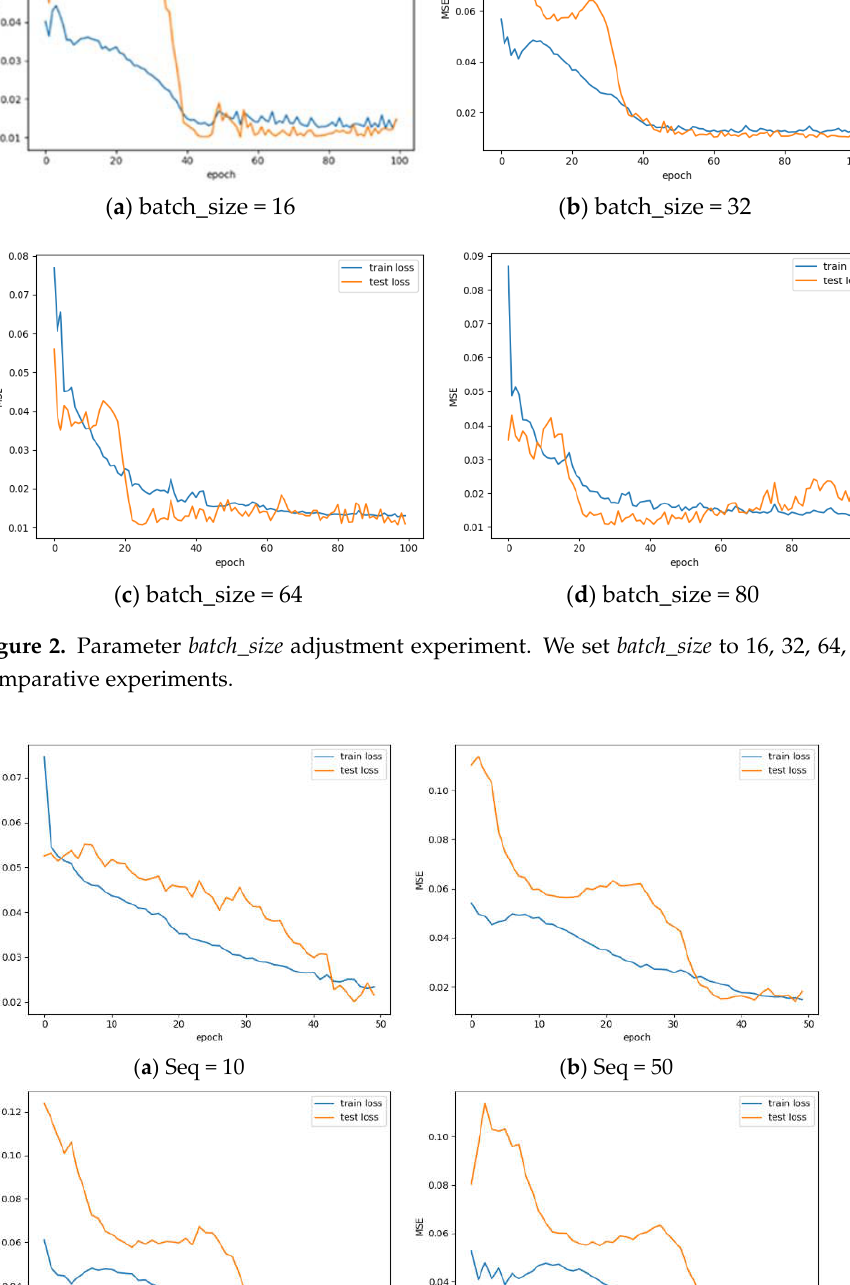
Figure 3. Parameter Seq adjustment experiment. We set Seq to 10, 50, 100, and 150 for comparative experiments.